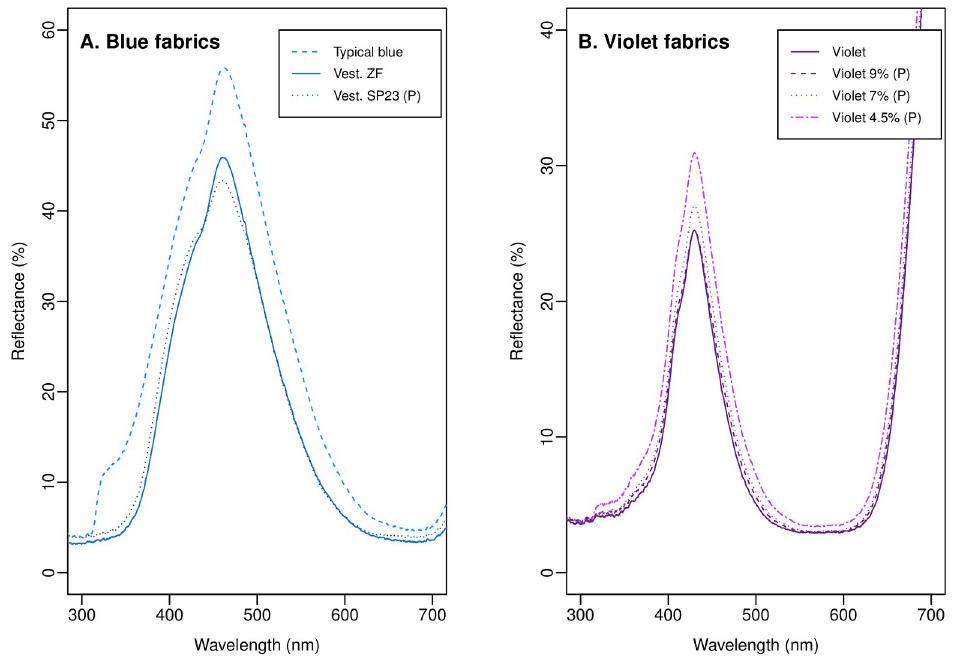
Fig 1. Reflectance spectra for the polyester fabrics tested in this work. (A) Typical blue is representative of the blue polyesters tested by [4]. Vest. ZF is the Vestergaard S.A. fabric currently used in the production of ZeroFly Tiny Targets, and Vest. SP23 (P) is a prototype variation on that fabric. (B) Violet is the improved violet fabric tested against savannah tsetse in Zimbabwe by [10]. The remaining violets designated (P) are unset prototypes produced using varying depths of the same dye. Spectra were measured using an Ocean Optics USB4000 spectrometer, PX-2 pulsed xenon light source flashing with a 30ms period, reflectance probe, and WS-1-SL standard (Ocean Insight Inc., Orlando, FL, USA). The reflectance probe was angled 45˚ to vertical and its tip was positioned 6 mm from the sample. A 120 ms integration period, boxcar width of 5, and 25 scans to average were used. Three replicate spectra were recorded for each of two reflectance probe azimuth angles on one side of the fabric. These replicates were averaged to produce the plotted functions.